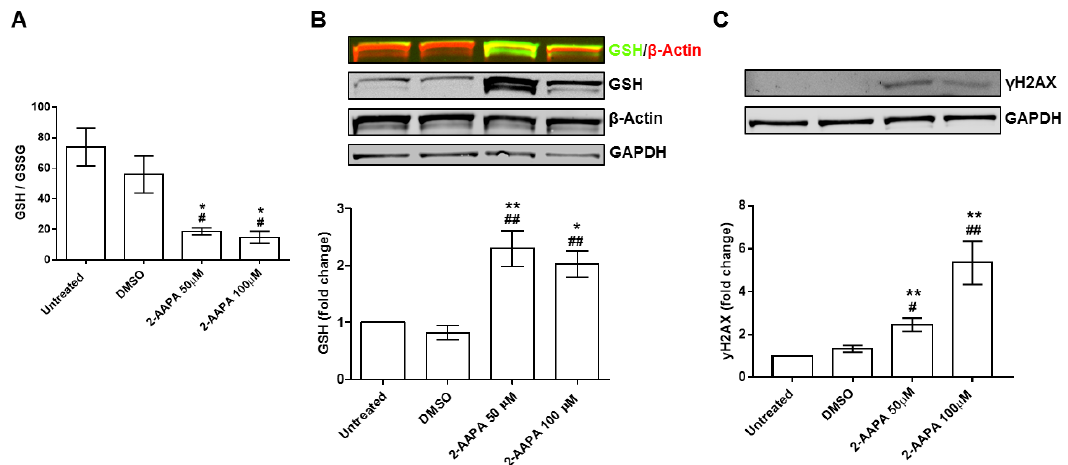
Figure 3. In vitro model of protein S-glutathionylation. ( A ) Bar graph representing the ratio between the reduced (GSH) and the oxidized (GSSG) form of glutathione (GSH / GSSG ratio) in human umbilical vein endothelial cells (HUVEC) after 4 h of treatment (2-AAPA 50 and 100 µ M) and 24 h of recovery ( n = 3). ( B ) Western blot representative images of HUVEC treated with 2-AAPA (50 and 100 µ M) for 4 h and 24 h of recovery ( n = 4); GSH is shown in green and β -actin is shown in red; Bar graph representing Western blot quantification by ImageJ. (* p < 0.05 vs. Untreated; ** p < 0.001 vs. Untreated; ## p < 0.001 vs. Dimethyl Sulfoxide (DMSO)). ( C ) Western blot evaluation of histone 2AX phosphorylation ( γ H2AX) in HUVEC after 2-AAPA (50 and 100 µ M) treatment for 4 h and 24 h of recovery ( n = 4); Bar graph representing Western blot quantification by ImageJ. (** p < 0.001 vs. Untreated; # p < 0.05 vs. DMSO; ## p < 0.01 vs. DMSO). Glyceraldehyde-3-Phosphate Dehydrogenase (GAPDH) has been used for normalization.